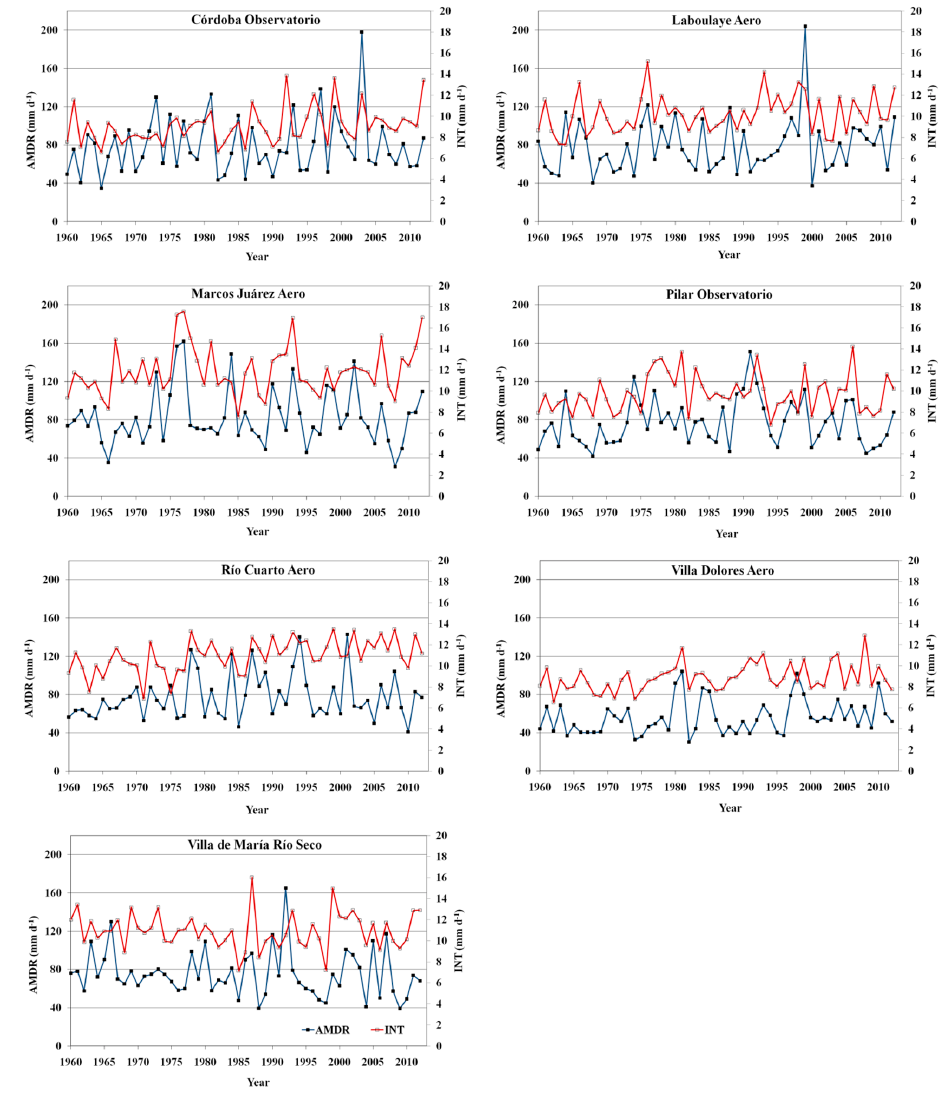
Figure 2. Annual variation of the mean intensity (INT) and the maximum daily value (AMDR) of rainfall at different weather stations of the central region of Argentina between 1960 and 2012. Two aspects are noteworthy in the behavior of these rainfall indicators in the region. The first is their marked interannual variability. Using the coefficient of variation to perform a comparative analysis of the variability, Table 1 shows that the variability of AMDR (between 31 and 39%) roughly doubles that of INT (14 and 19%) at each of the weather stations, with Pilar Observatorio (PI) being the only one with a slightly lower ratio (1.67). The other aspect to be highlighted is the positive correlation between both indices (with a rank of 0.39–0.57 between stations) which, although it expresses a significant linear relationship, also suggests that each variable retains some particular behavior.